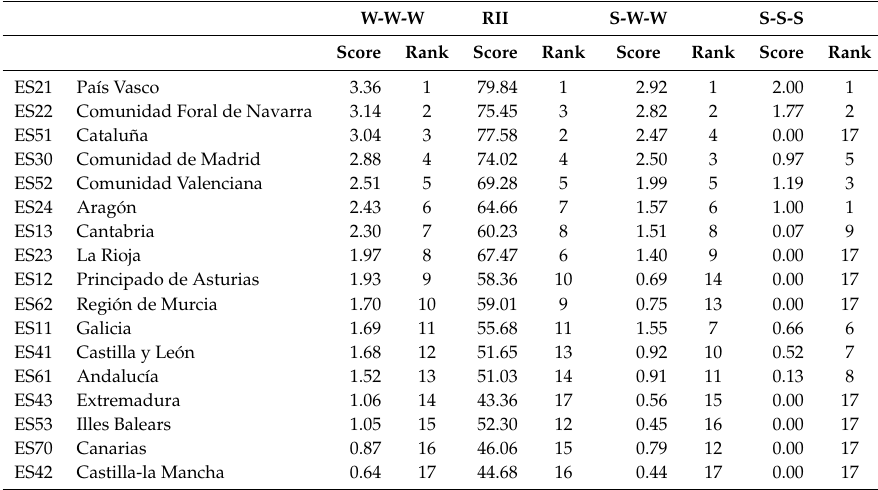
Table 4. Spain Regions’ innovation performance in 2019 relative to RII and MRP-WSCI: Spanish reference